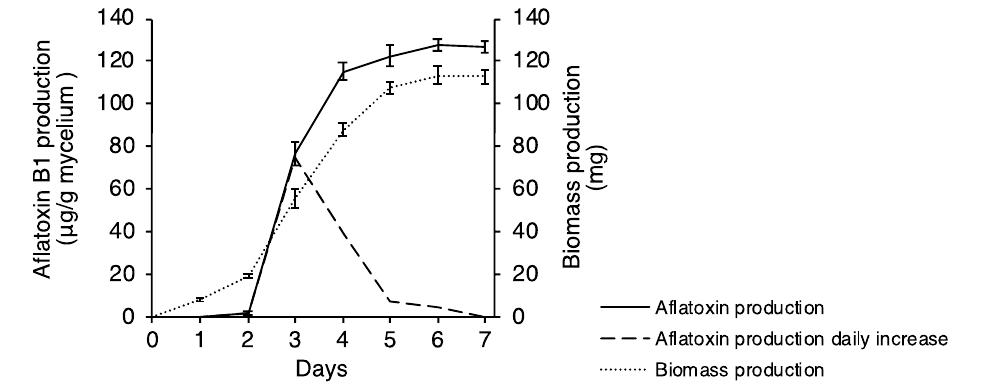
Figure 1. Aflatoxin production and biomass production of A. flavus KCCM60330 in float